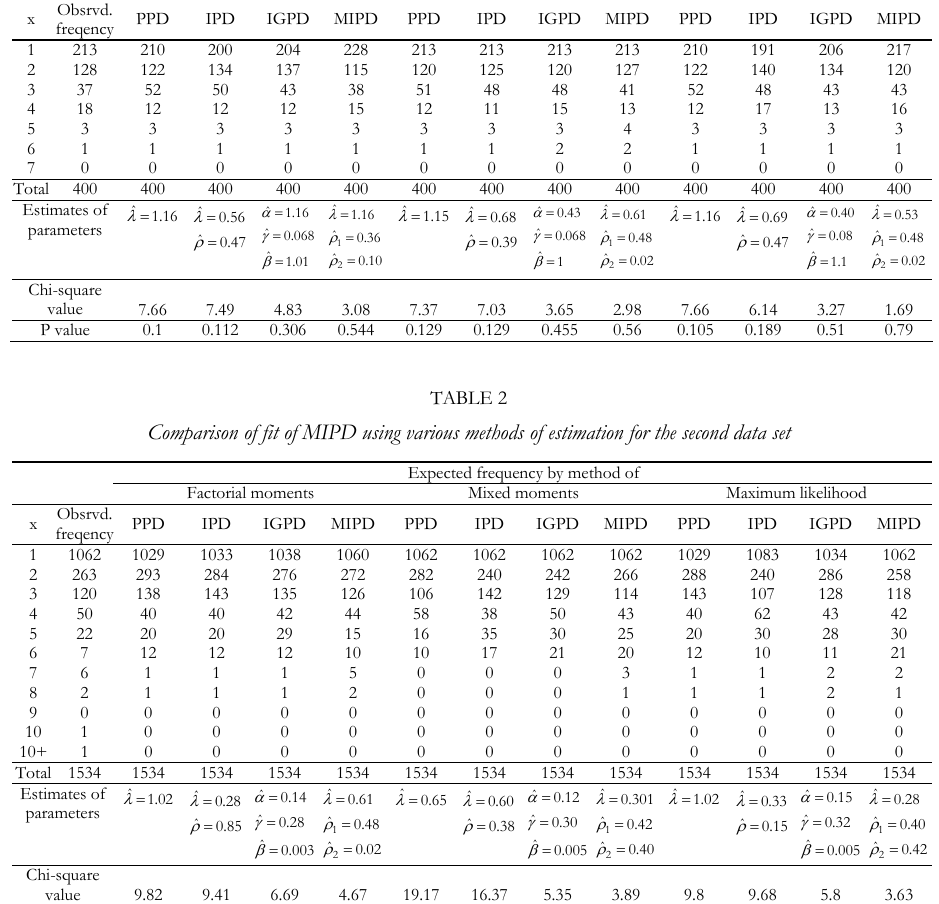
Comparison of fit of MIPD using various methods of estimation for the first data set Expected frequency by method of Factorial moments Mixed moments Maximum likelihood